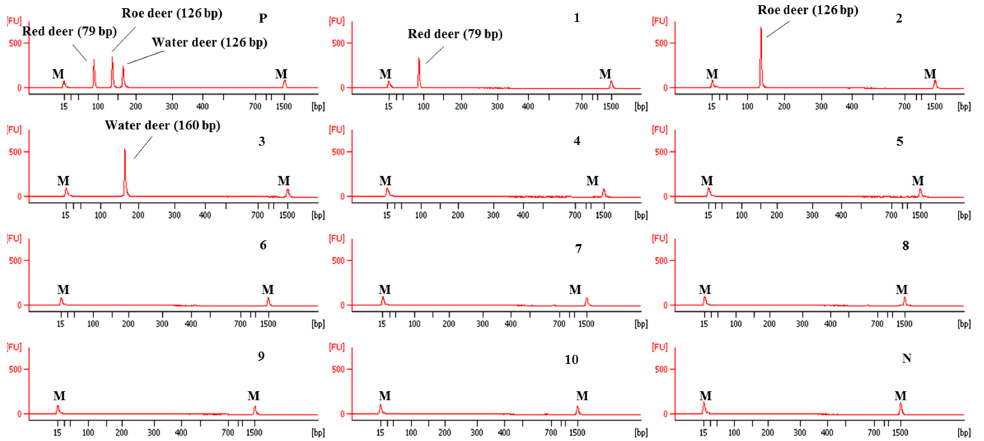
Figure 3. Electropherograms of specificity result of the multiplex PCR assay for red deer, roe deer, and water deer. FU: fluorescence, M: alignment marker, lane P: positive control (red deer, roe deer, and water deer), lane 1: red deer, 2: roe deer, 3: water deer, 4: beef, 5: pork, 6: lamb, 7: goat, 8: horse, 9: chicken, 10: duck, and N: non-template.